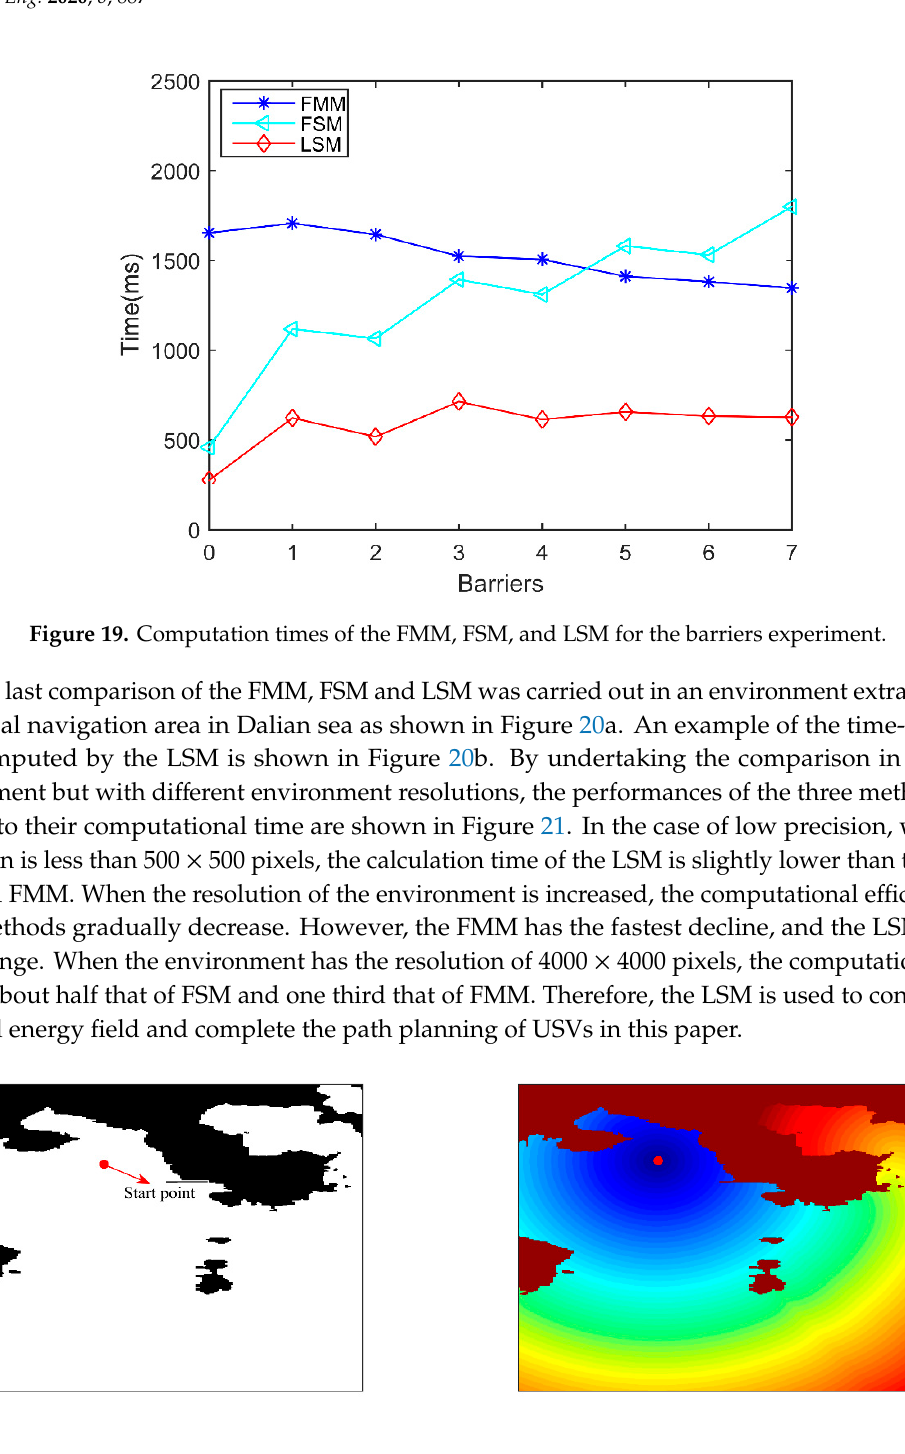
Figure 18. Example of the resulting time-of-arrival field applying the LSM to the environments with